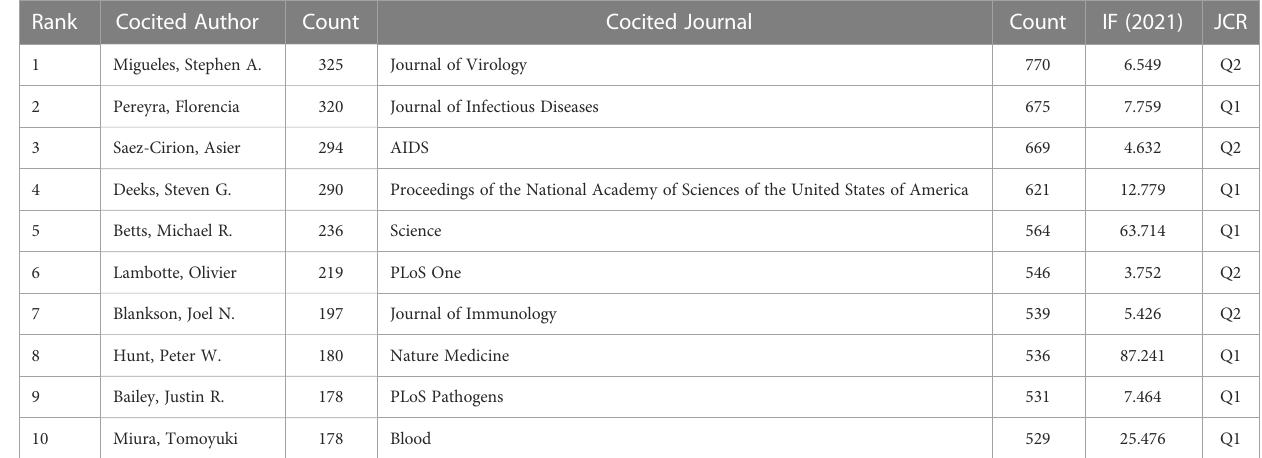
TABLE 4 The top ten authors and journals with the most